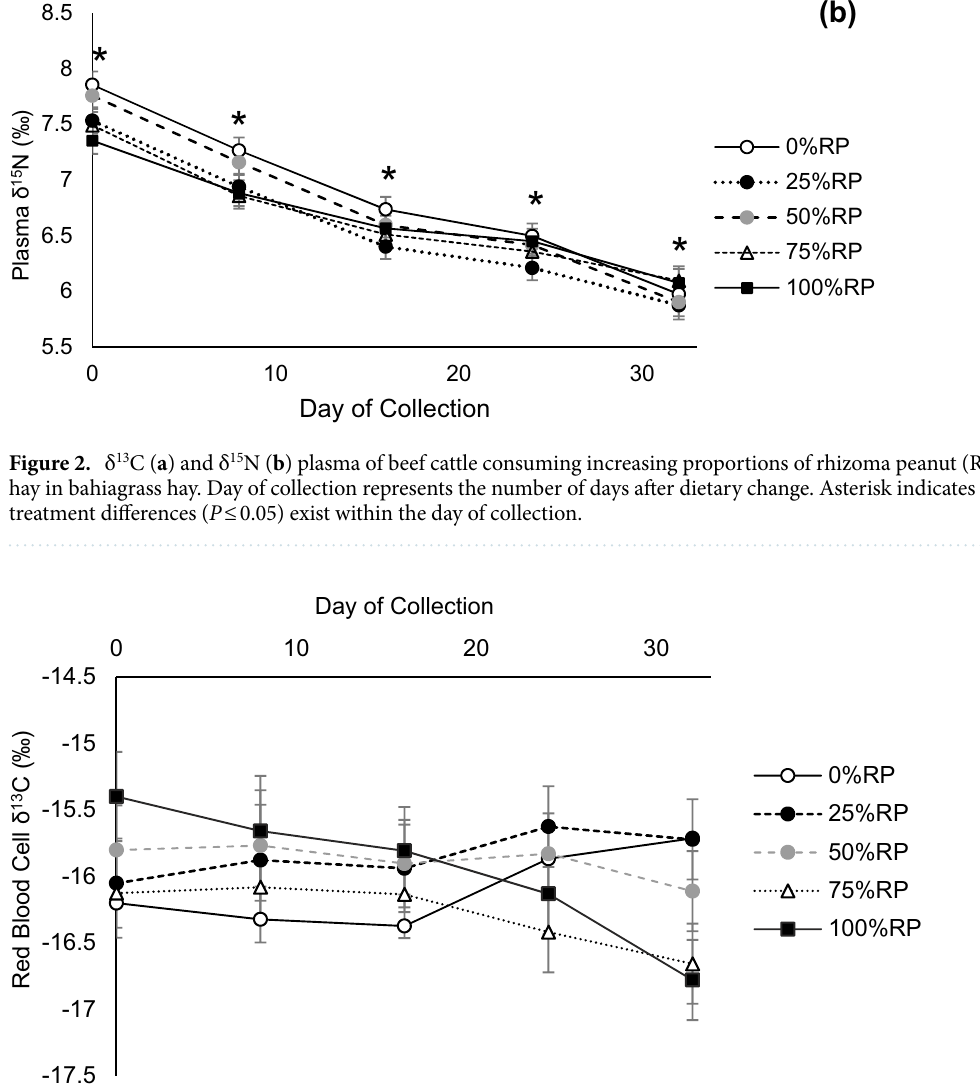
-17.5 Figure 3. δ 13 C of red blood cells (RBC) of beef cattle consuming increasing proportions of rhizoma peanut (RP) in bahiagrass hay. Day of collection represents the number of days after dietary